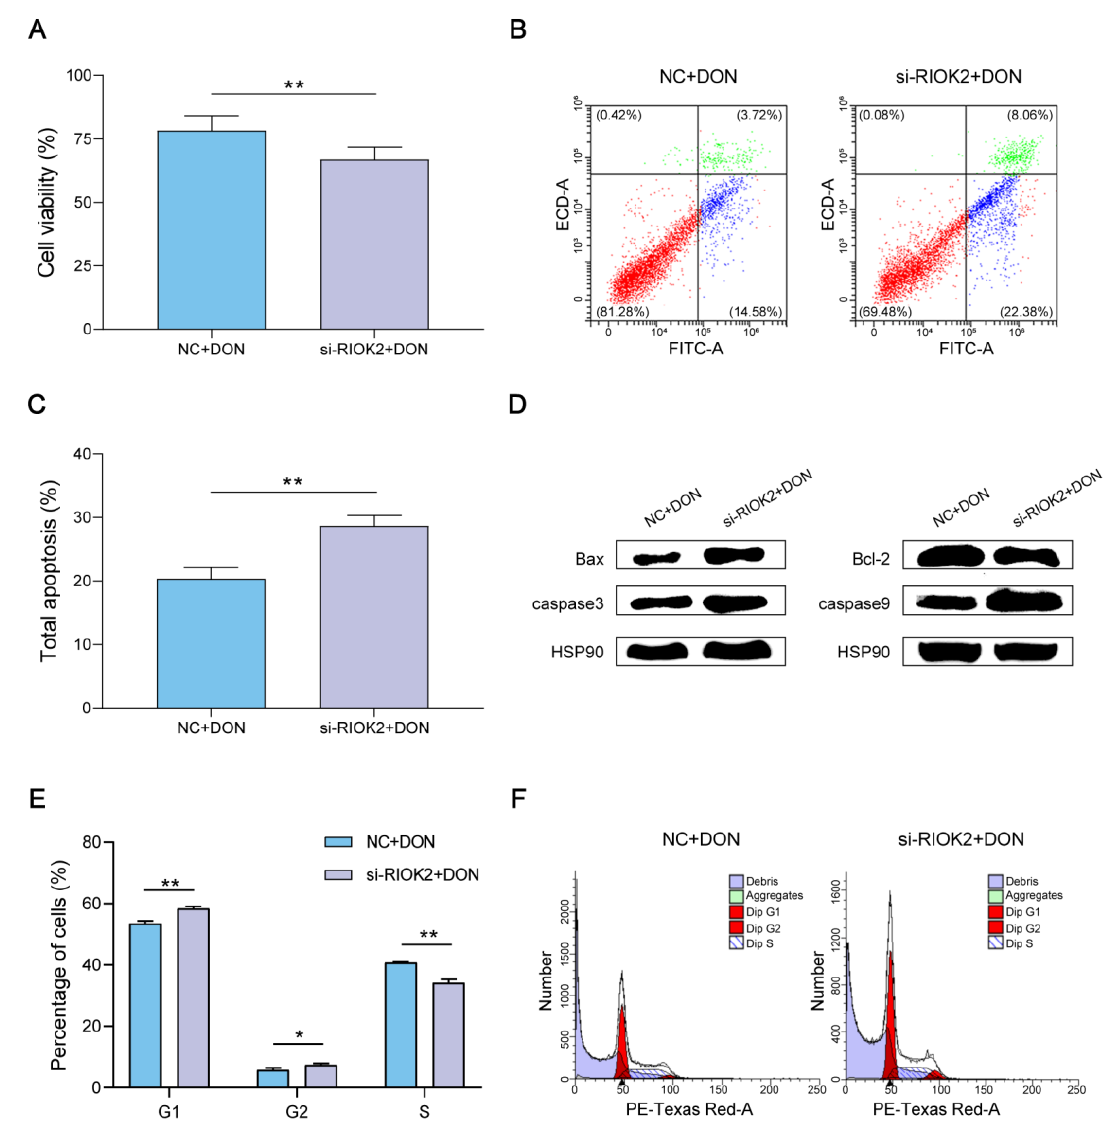
Figure 2. Silencing RIOK2 induced proliferation inhibition, apoptosis, and cell cycle arrest in DON- induced IPEC-J2. ( A ) The proliferation ability analysis of IPEC-J2 using the cell viablity assay. ( B , C ) Apoptotic assay by flow cytometry. Apoptotic cells were Annexin V-positive and PI (propidium iodide)-negative. ( D ) Western blotting analysis of the changes in the protein levels of related apoptosis factors (Bax, Bcl-2, caspase3, and caspase9). ( E , F ) Analysis of percentage of IPEC-J2 using flow cytometry. IPEC-J2 were transfected with si- RIOK2 or the negative control, and were treated with DON for 48 h. Each experiment was replicated at least three times, and data are presented as mean values ± SD. * p < 0.05, ** p < 0.01.